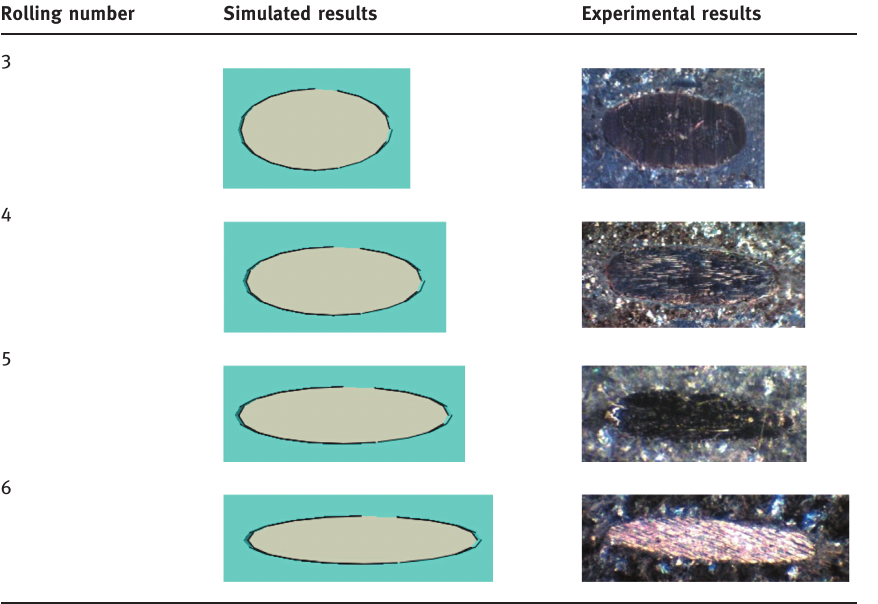
Figure 10: Experimental route. Table 6: Experimental and simulated results. Rolling